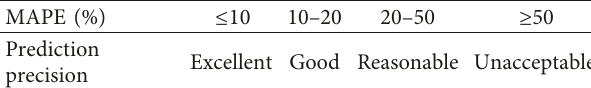
Table 1: The MAPE criteria of prediction precision. MAPE (%)